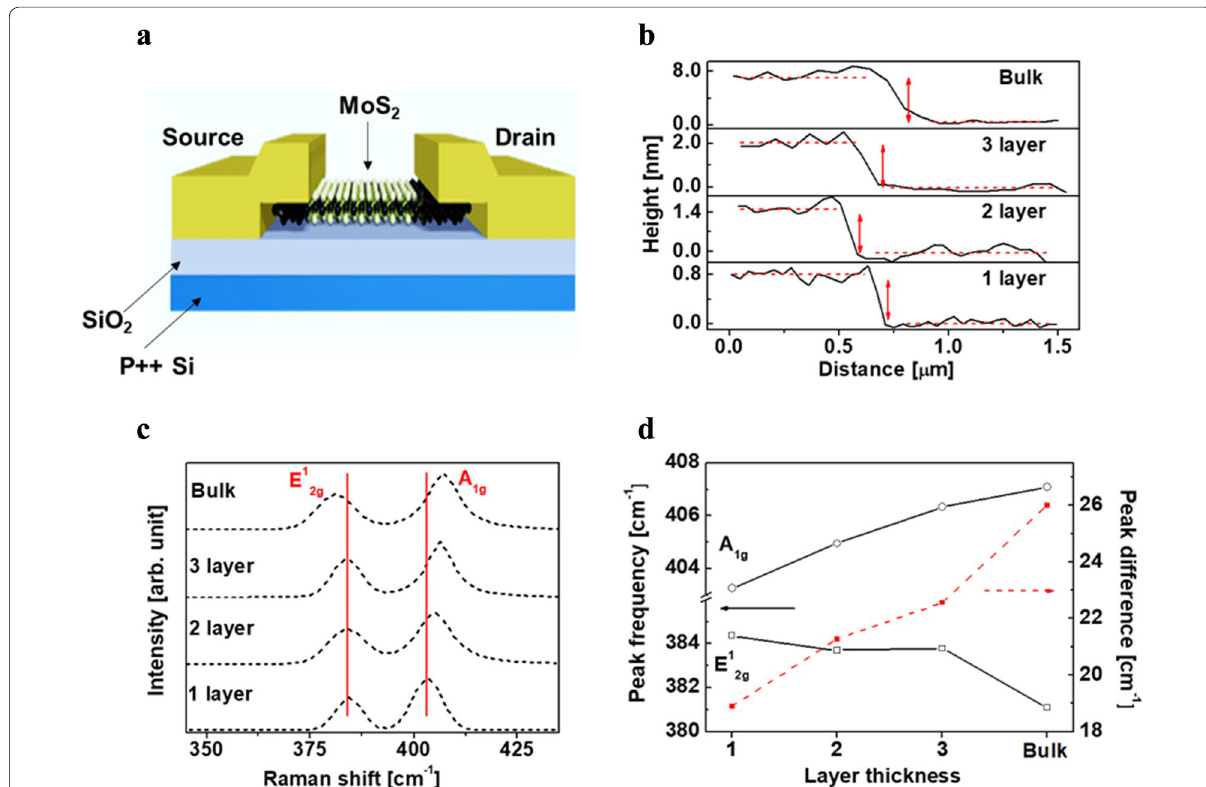
Fig. 1 a Schematic diagram of the conventional bottom gate structure MoS 2 photo-TFT, b height profile of the MoS 2 layers, c Raman spectra of MoS 2 samples with different numbers of layers. The left and right red lines indicate the positions of the E 1 2g and A 1g peaks in the mono-layer MoS 2 , respectively. d Frequencies of the E 1 2g and A 1g Raman peaks (left side axis) and their difference (right side axis) with different numbers of MoS 2